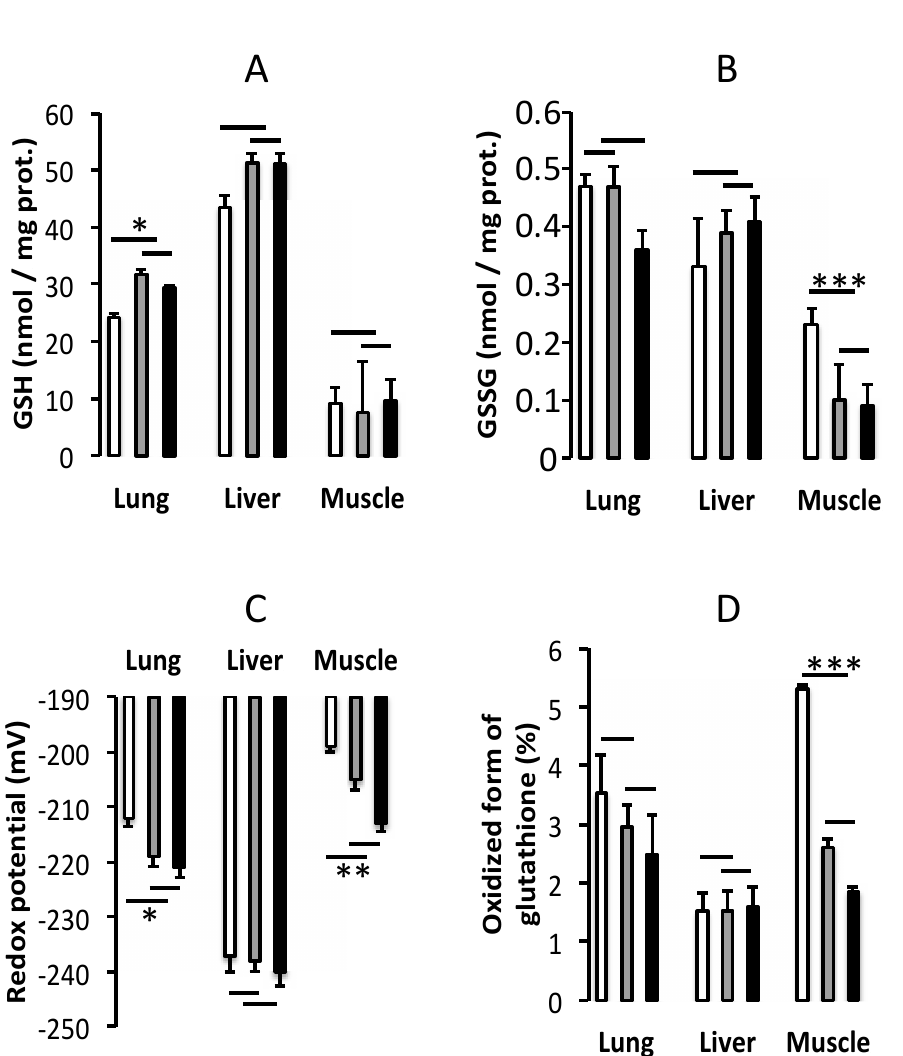
Figure 3. Glutathione. Reduced form of glutathione (GSH) ( A ), oxidized form of glutathione (GSSG) ( B ), redox potential ( C ), and proportion of glutathione in oxidized form ( D ) in lungs, liver, and gastrocnemius muscle. White column: PN (Parenteral nutrition). Gray column: PN + 10 µM GSSG. Black column: Reference group (animals fed orally). Data are expressed as mean ± S.E.M., n = 7–8 per group. The bars show the statistical comparisons. The absence of a symbol on the bar means that p > 0.05. *: p < 0.05; **: p < 0.01; ***: p < 0.001.